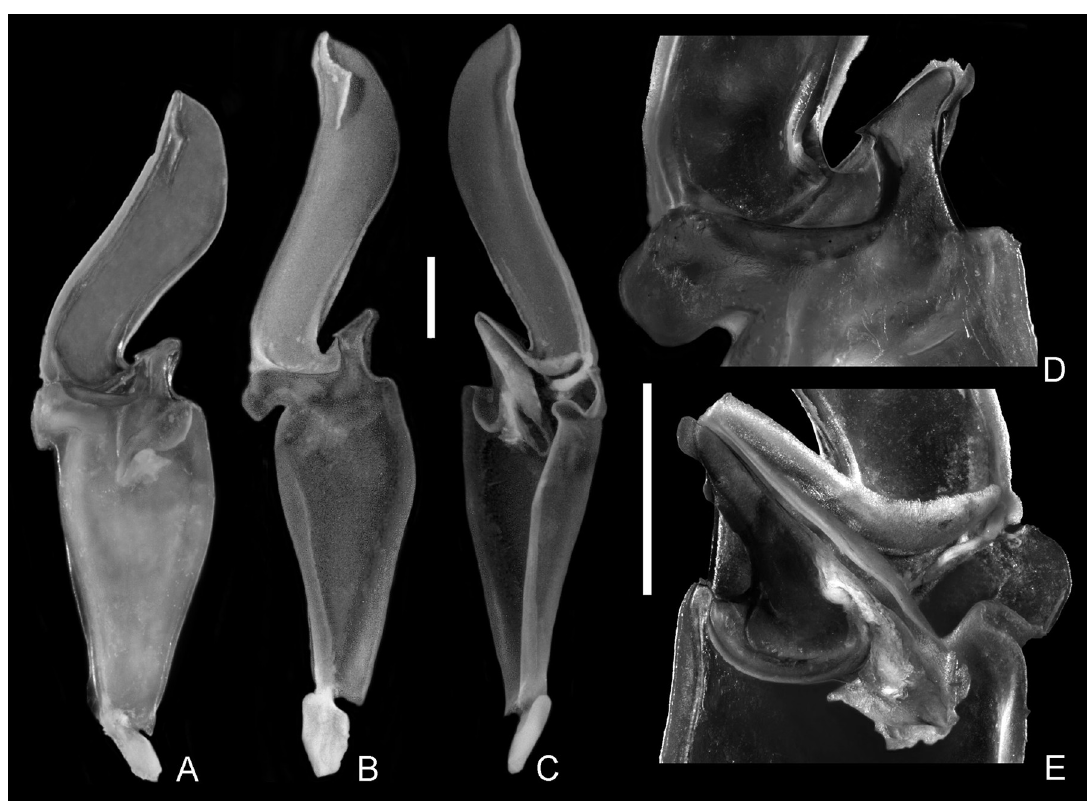
Fig 7. Hemispermatophore of Bothriurus coriaceus and Bothriurus mistral n. sp. (A–E) (A) Bothriurus coriaceus , left hemispermatophore, external aspect. (B–E) Bothriurus mistral n. sp. Left hemispermatophore (B) External aspect. (C) Internal aspect. (D) Detail of the internal lobe. (E) Detail of lobe region. Scale bars: 1